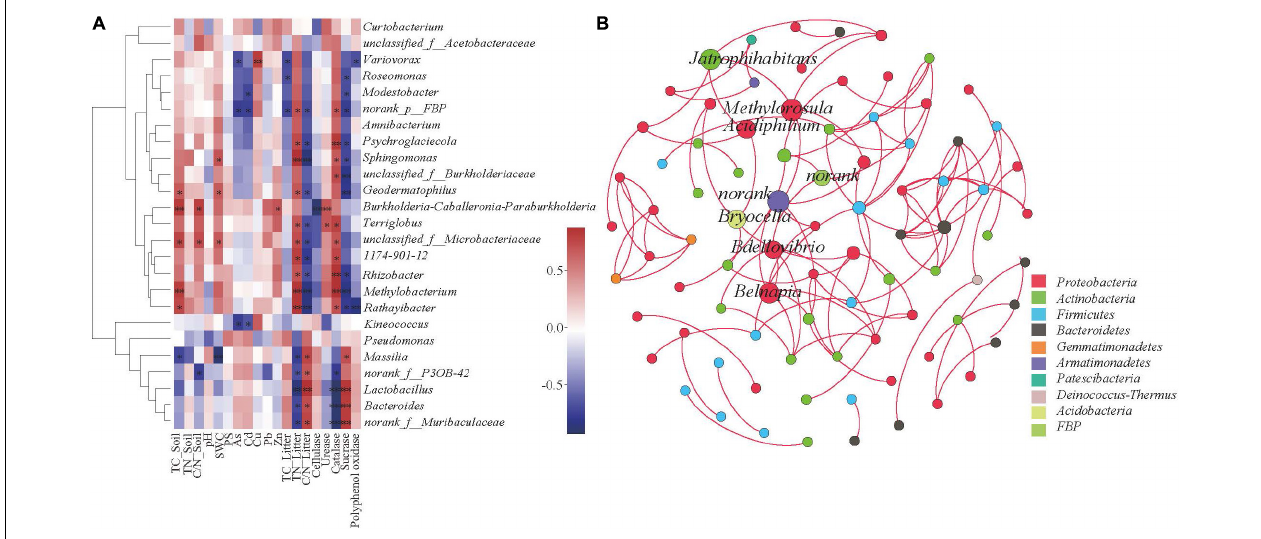
FIGURE 6 | Correlation heat map of the top 25 genus (A) and soil and vegetation properties. The X and Y axis represent environmental factors and phyla, respectively. R is shown in different colors, where the right side of the legend is the color range of the different r values. * P < 0.05; ** P < 0.01. The Co-occurrence network of bacterial taxa in litter. Nodes represent bacteria genus (B) , while red edges represent positive connections between species pairs, respectively.